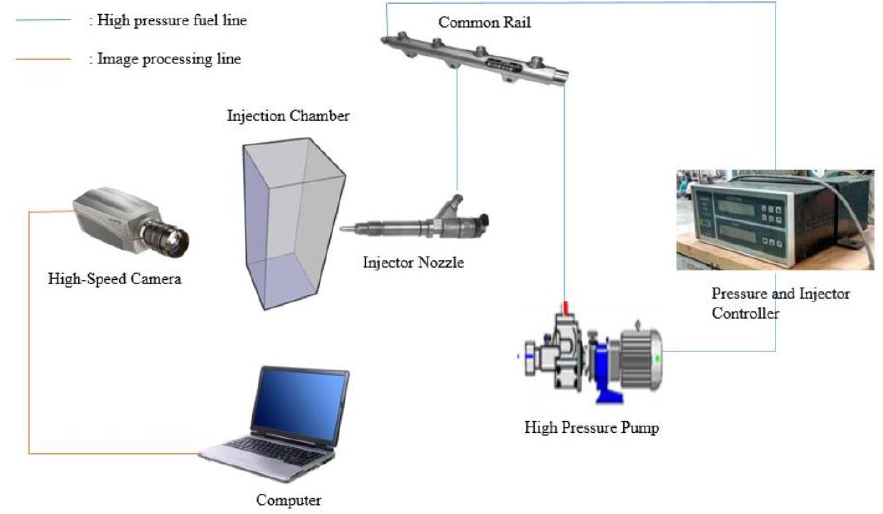
Figure 5. Visualization spray test platform.